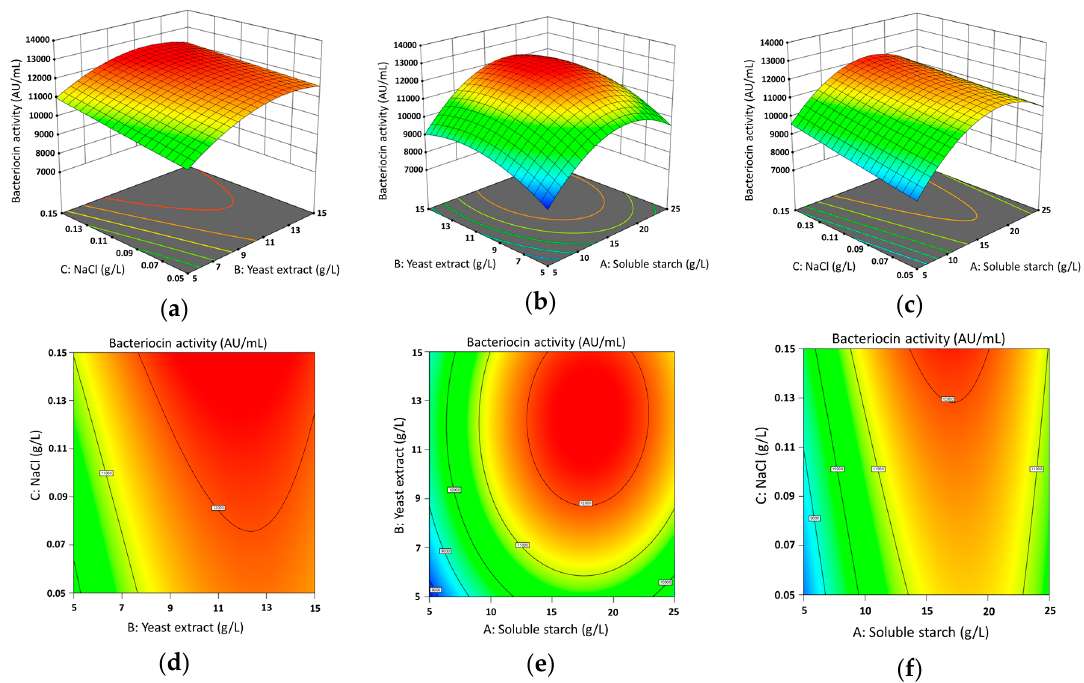
Figure 2. The plot of the system (3D) for response surface methodology showing the mutual and distinct effects of the variables on Bacteriocin activity (AU/mL). ( a , d ) optimized bacteriocin activity with the interaction between of yeast extract (g/L) and NaCl (g/L), ( b , e ) optimized bacteriocin activity with the interaction between of soluble starch (g/L) and yeast extract (g/L), ( c , f ) optimized bacteriocin activity with the interaction between of soluble starch (g/L) and NaCl (g/L).